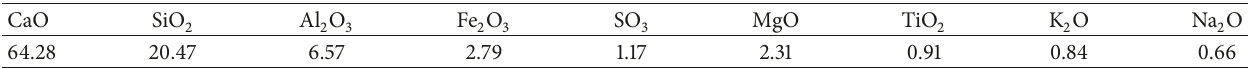
Figure 1: Preparation of the filling material. Table 1: Chemical composition of ordinary Portland cement (%).